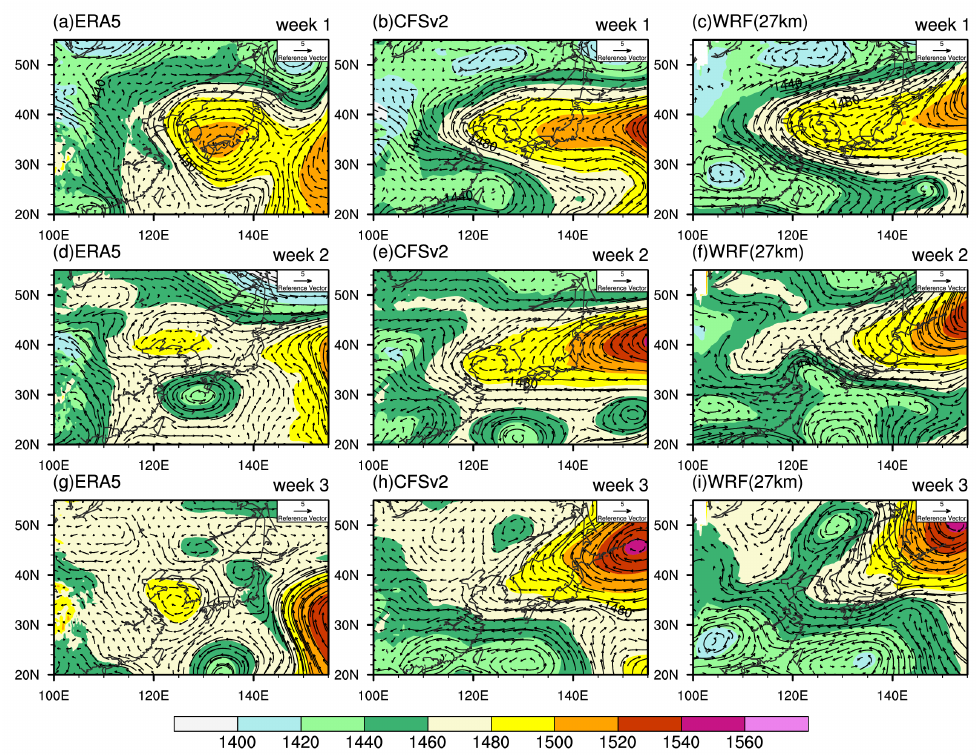
Figure 8. Spatial patterns of the mean geo-potential height (shaded contour, m) and wind vector (vector, m/s) at 850 hPa during Weeks 1–3 in CASE